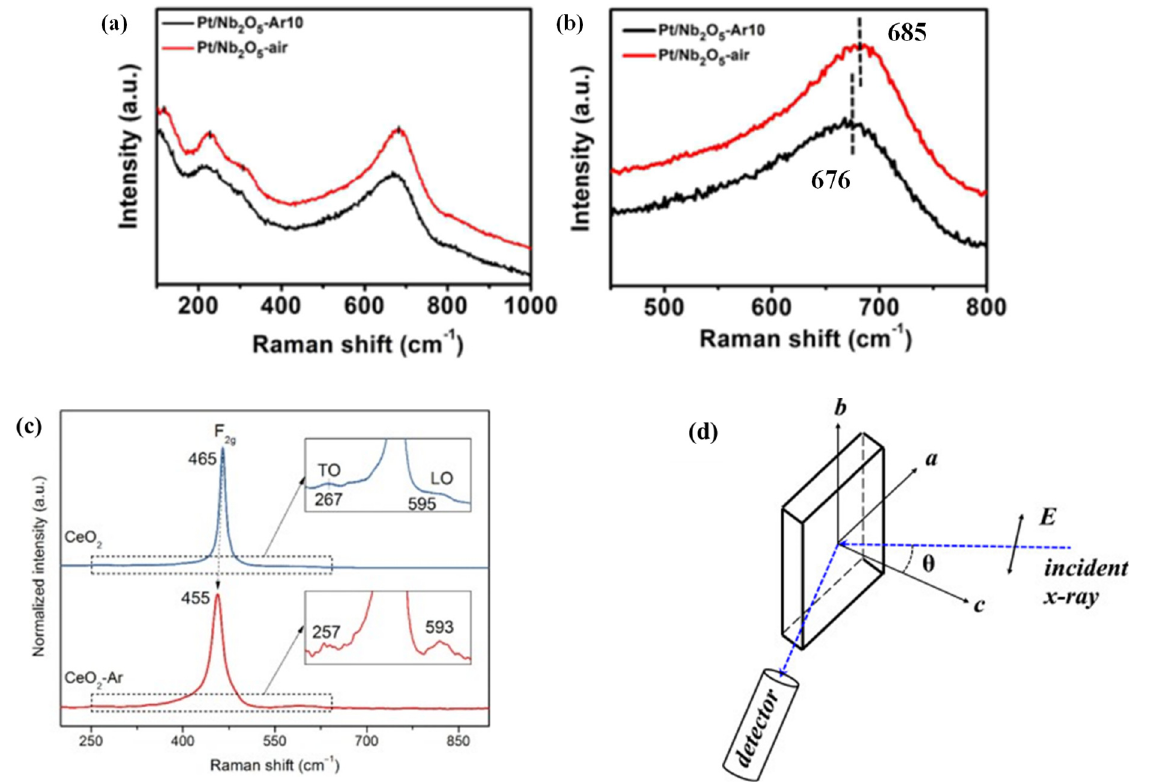
Figure 4. ( a ) Raman spectra of the representative Pt–based catalysts and ( b ) magnification of the peaks located at 450–800 cm − 1 . ( c ) Raman spectra of the CeO 2 and CeO 2 -Ar catalysts. ( d ) Schematic diagram of the polarized EXAFS measurement geometry [93–96].